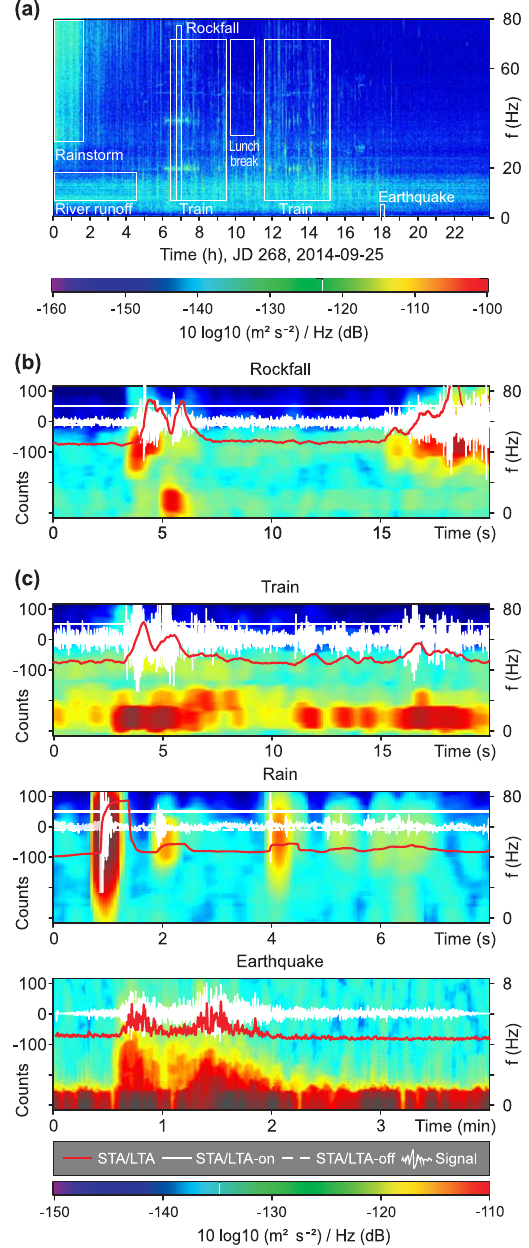
Figure 5. Example day (25 September 2014) showing seismic char- acteristics of environmental sources in the Lauterbrunnen Valley. (a) 24h PSD with interpreted sources indicated. Data recorded at station “Mosquito Fabric” and filtered between 1 and 90Hz. (b) Seismic record of rockfall event 7 (Table 2). (c) Seismic records of other sources registered by the station “Gate of China”. Note change in axes scales for the earthquake event. Panels (b) and (c) contain the PSD (background image; colour bar applies to b and c ) and waveform data (semitransparent line graph) as well as the picker algorithm characteristics (STA-LTA-ratio, “on” and “off”